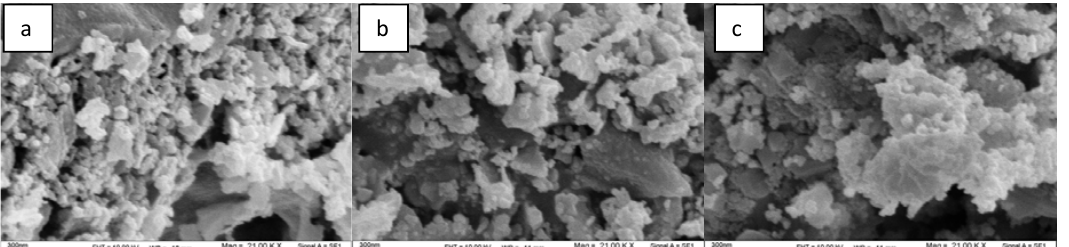
O samples: a)NiFe 2 4